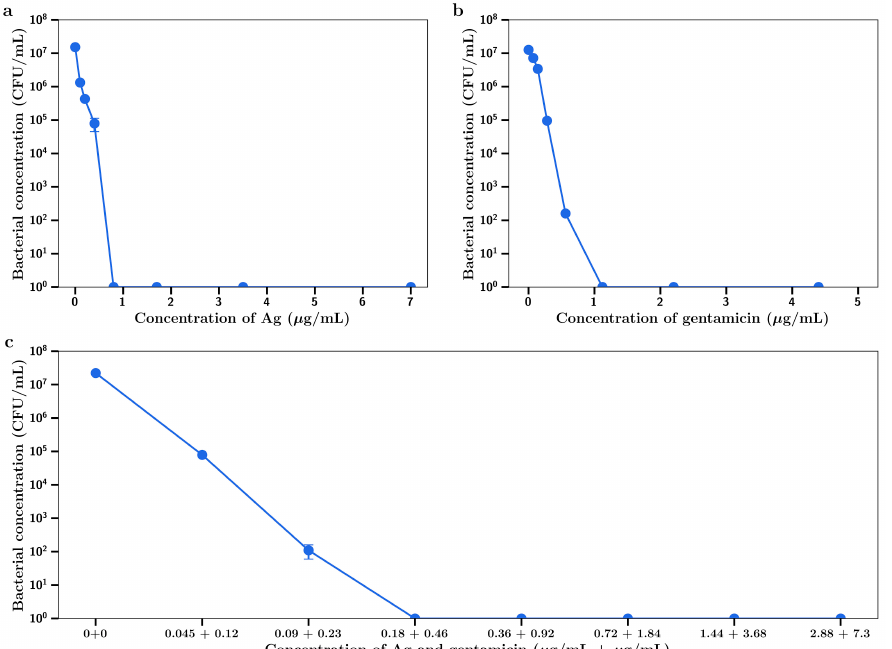
Figure 9. Bacterial concentrations of P. aeruginosa incubated with day 7 release media from ( a ) Ag- releasing bone cement, ( b ) gentamicin-releasing bone cement, ( c ) Ag + gentamicin-releasing bone cement ( n = 3).